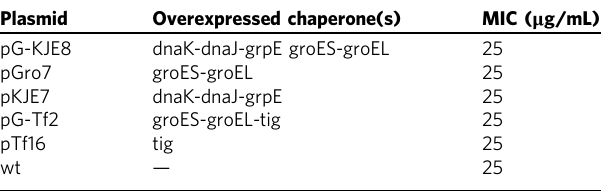
Table 3 MIC of P2 after chaperone overexpression in BL21 Plasmid Overexpressed chaperone(s) MIC ( μ g/mL) pG-KJE8 dnaK-dnaJ-grpE